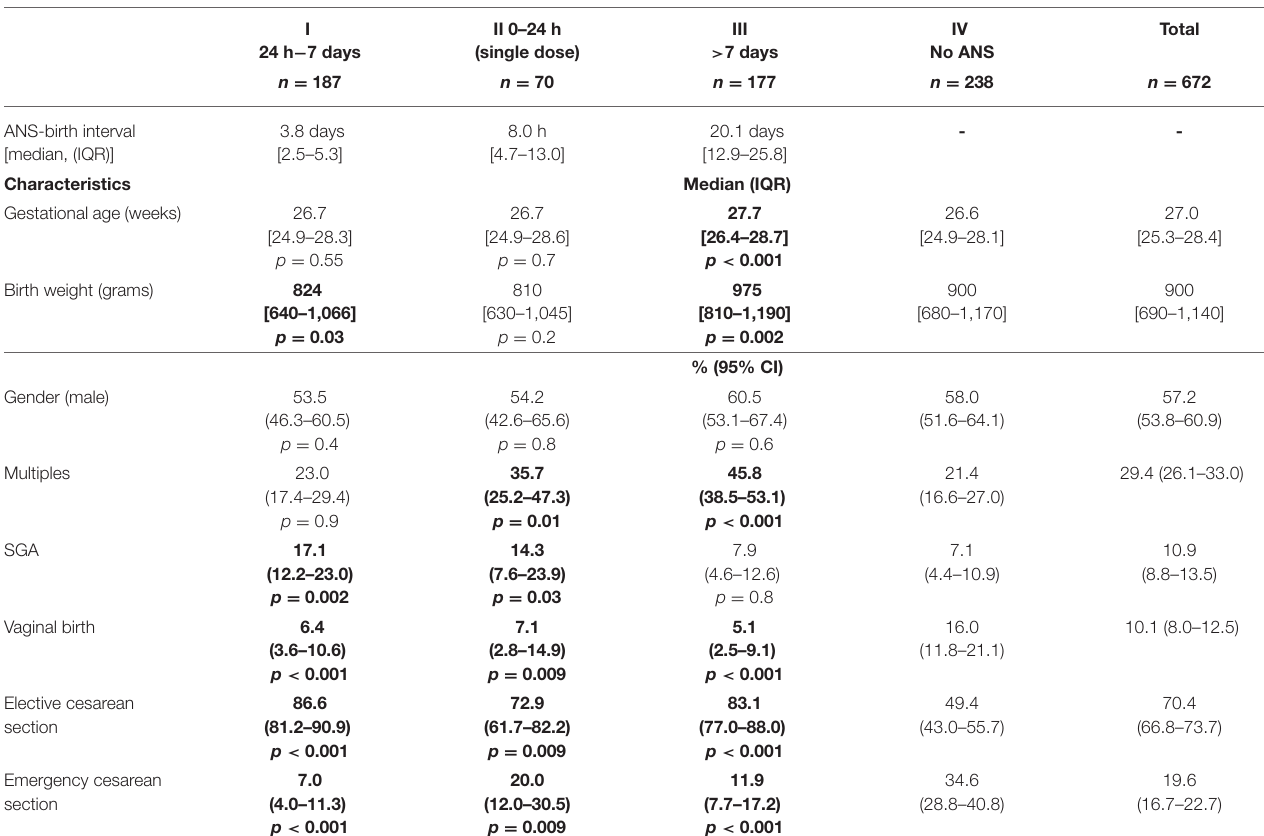
TABLE 2 | Cohort characteristics by ANS timing